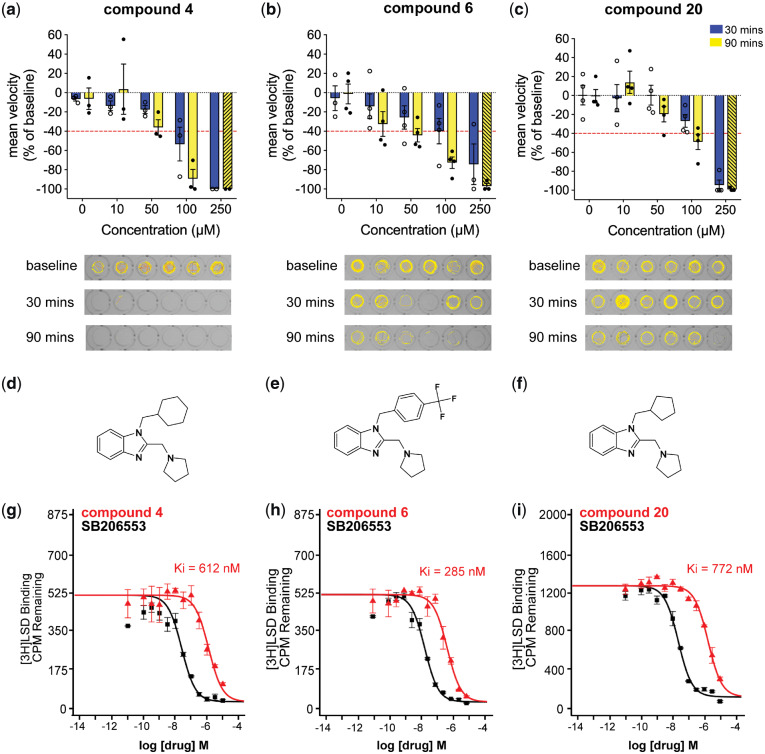

Evaluation of clemizole analogues that reduce seizure-like swim behaviour in scn1lab mutant zebrafish. Clemizole analogues identified as positive from the in vivo screen were freshly synthesized and retested for efficacy in suppressing the seizure-like swimming behaviour of 5 dpf scn1Lab mutant zebrafish. Graphs show the change in mean velocity over four concentrations of (a) compound 4, (b) compound 6 and (c) compound 20. Each bar represents the mean change in velocity ± SEM from three independent experiments (six individual larva per experiment). Toxicity is indicated by dashed bars. The threshold for a decrease in velocity is ≥40% (red line). Locomotion of larvae was recorded for 10 min after an exposure of 30 min (blue bars) and 90 min (yellow bars). A representative raw 10 min tracking plot is shown for a single experiment of six individual scn1Lab zebrafish. The chemical structure for each clemizole analogue is shown (d–f). In vitro radioligand binding analyses of (g) compound 4, (h) compound 6 and (i) compound 20 revealed specificity for 5-HT2BR over 5-HT2R subtypes. SB206553 was used as a positive control for 5-HT2BR binding (black). The binding affinity for the other clemizole analogues is given in Supplementary Table S2.